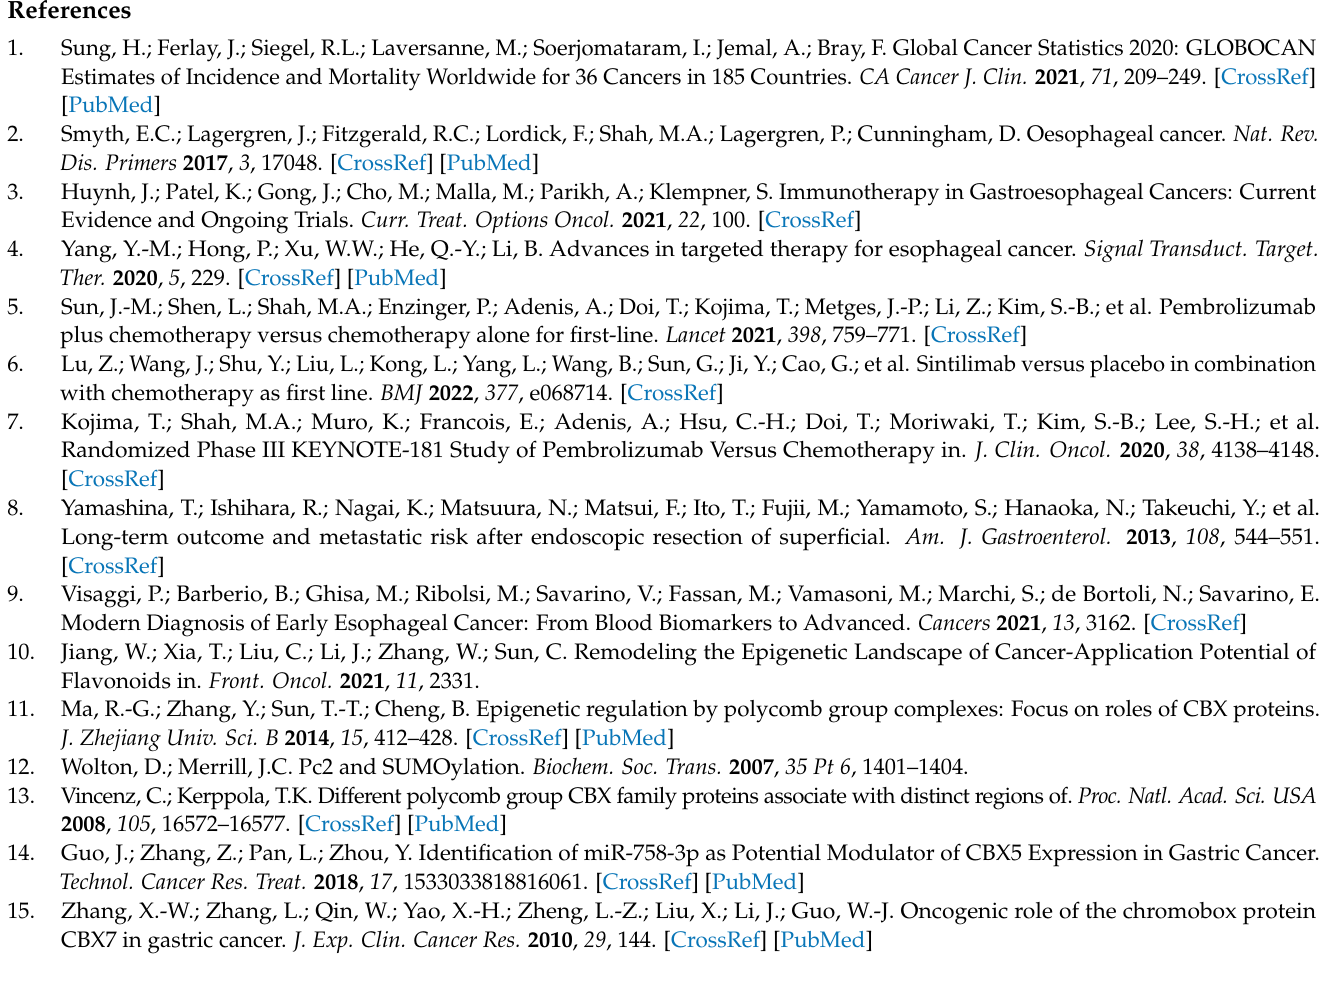
Figure S4: Relationships between mRNA expression of CBX family proteins and immunoregulators based on TISIDB database; Figure S5: The knock-down efficiency of CBX3 siRNA in Kyse150 and Kyse 510 cell lines were confirmed by western